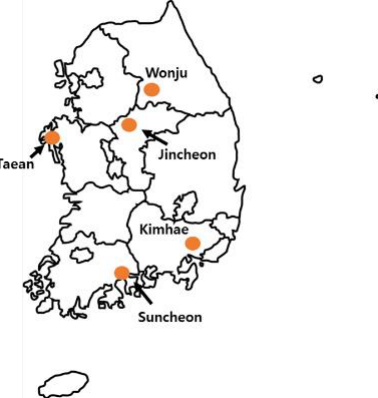
Figure 1. Sampling map in Korea.